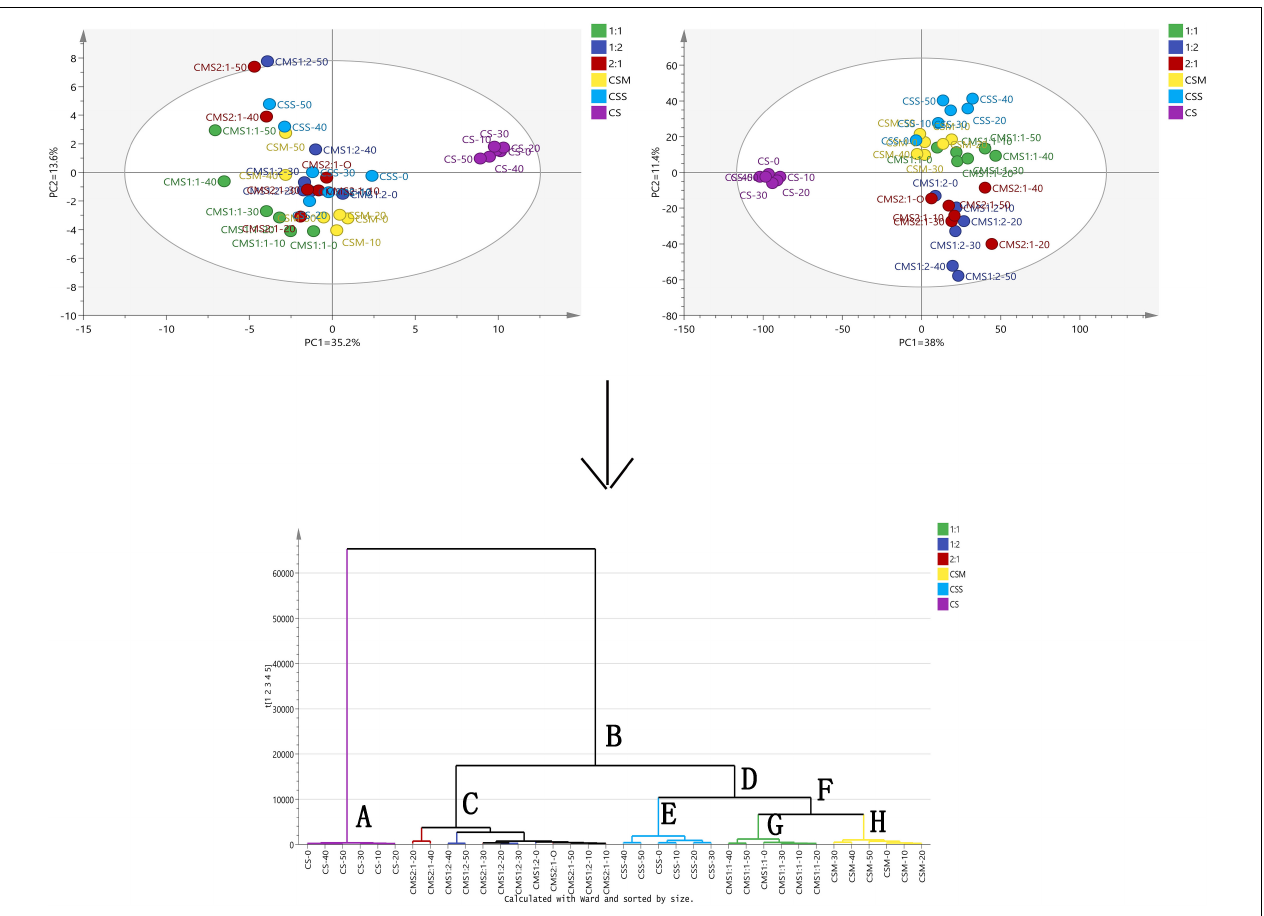
FIGURE 5 | Principal component analysis, orthogonal partial least squares discriminant analysis and hierarchical cluster analysis (HCA) of volatile components in cheese. The left and right figures represent the PCA and OPLS-DA results of different processed cheese samples, and the bottom figure represents the HCA results. CS, CSM, CSS, CSM:CSS 1:1, CSM:CSS 1:2 and CSM:CSS 2:1 indicate the use of the commercial starter (Control group), K. marxianus B13–5, S. cerevisiae DL6–20, K. marxianus B13–5: S. cerevisiae DL6–20 1:1, K. marxianus B13–5: S. cerevisiae DL6–20 1: 2, and K. marxianus B13–5: S. cerevisiae DL6–20